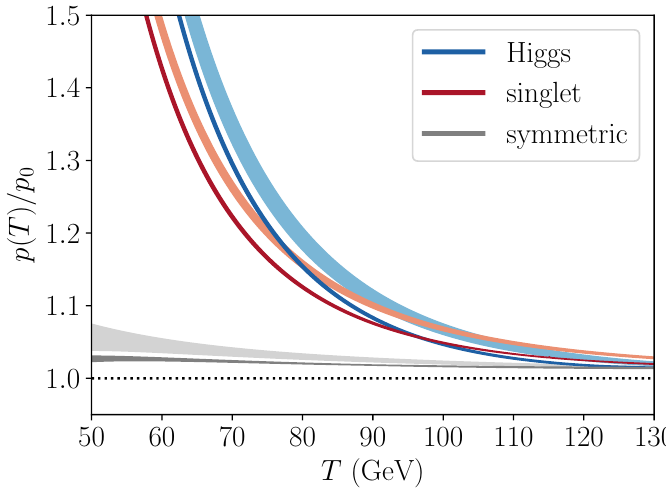
Figure 2 . Pressure of each phase as function of temperature, normalised by the leading order pressure p 0 . Bands correspond to varying the 4d RG scale µ between 0 . 5 πT and 2 πT . Darker colours correspond to N 3 LO computation, and lighter colours to a mere one-loop approximation. The result of the N 3 LO computation is less sensitive to the RG scale, and corrections to p 0 in all phases are mildly smaller than in the mere one-loop approximation.